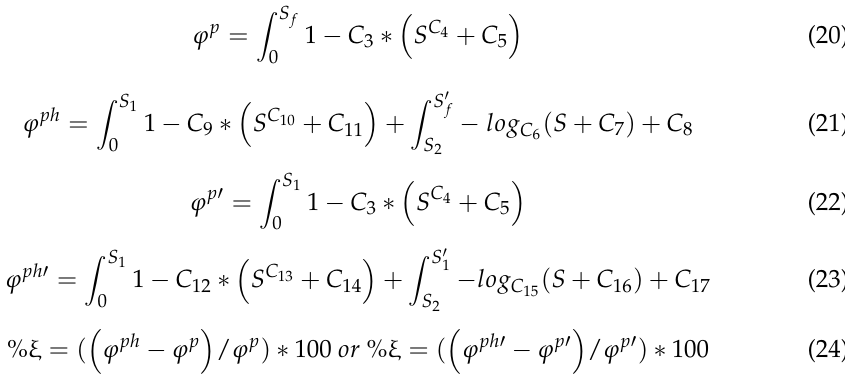
Figure 16. Schematic representation to identify 𝑆 (cid:2869)(cid:4593) and corresponding areas when conducting LASH (RP after 𝑆 (cid:3033) ).